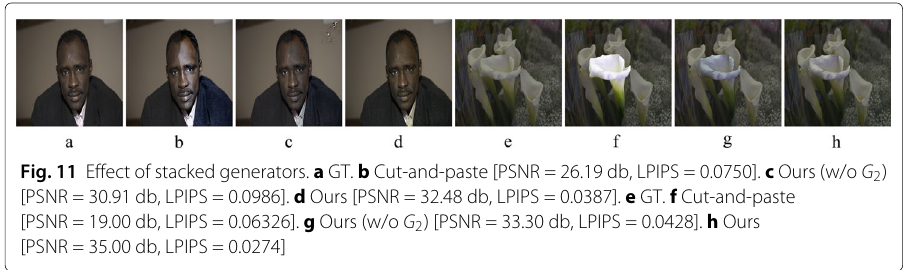
Fig. 11 Effect of stacked generators. a GT. b Cut-and-paste [PSNR = 26.19 db, LPIPS = 0.0750]. c Ours (w/o G 2 ) [PSNR = 30.91 db, LPIPS = 0.0986]. d Ours [PSNR = 32.48 db, LPIPS = 0.0387]. e GT. f Cut-and-paste [PSNR = 19.00 db, LPIPS = 0.06326]. g Ours (w/o G 2 ) [PSNR = 33.30 db, LPIPS = 0.0428]. h Ours [PSNR = 35.00 db, LPIPS = 0.0274]